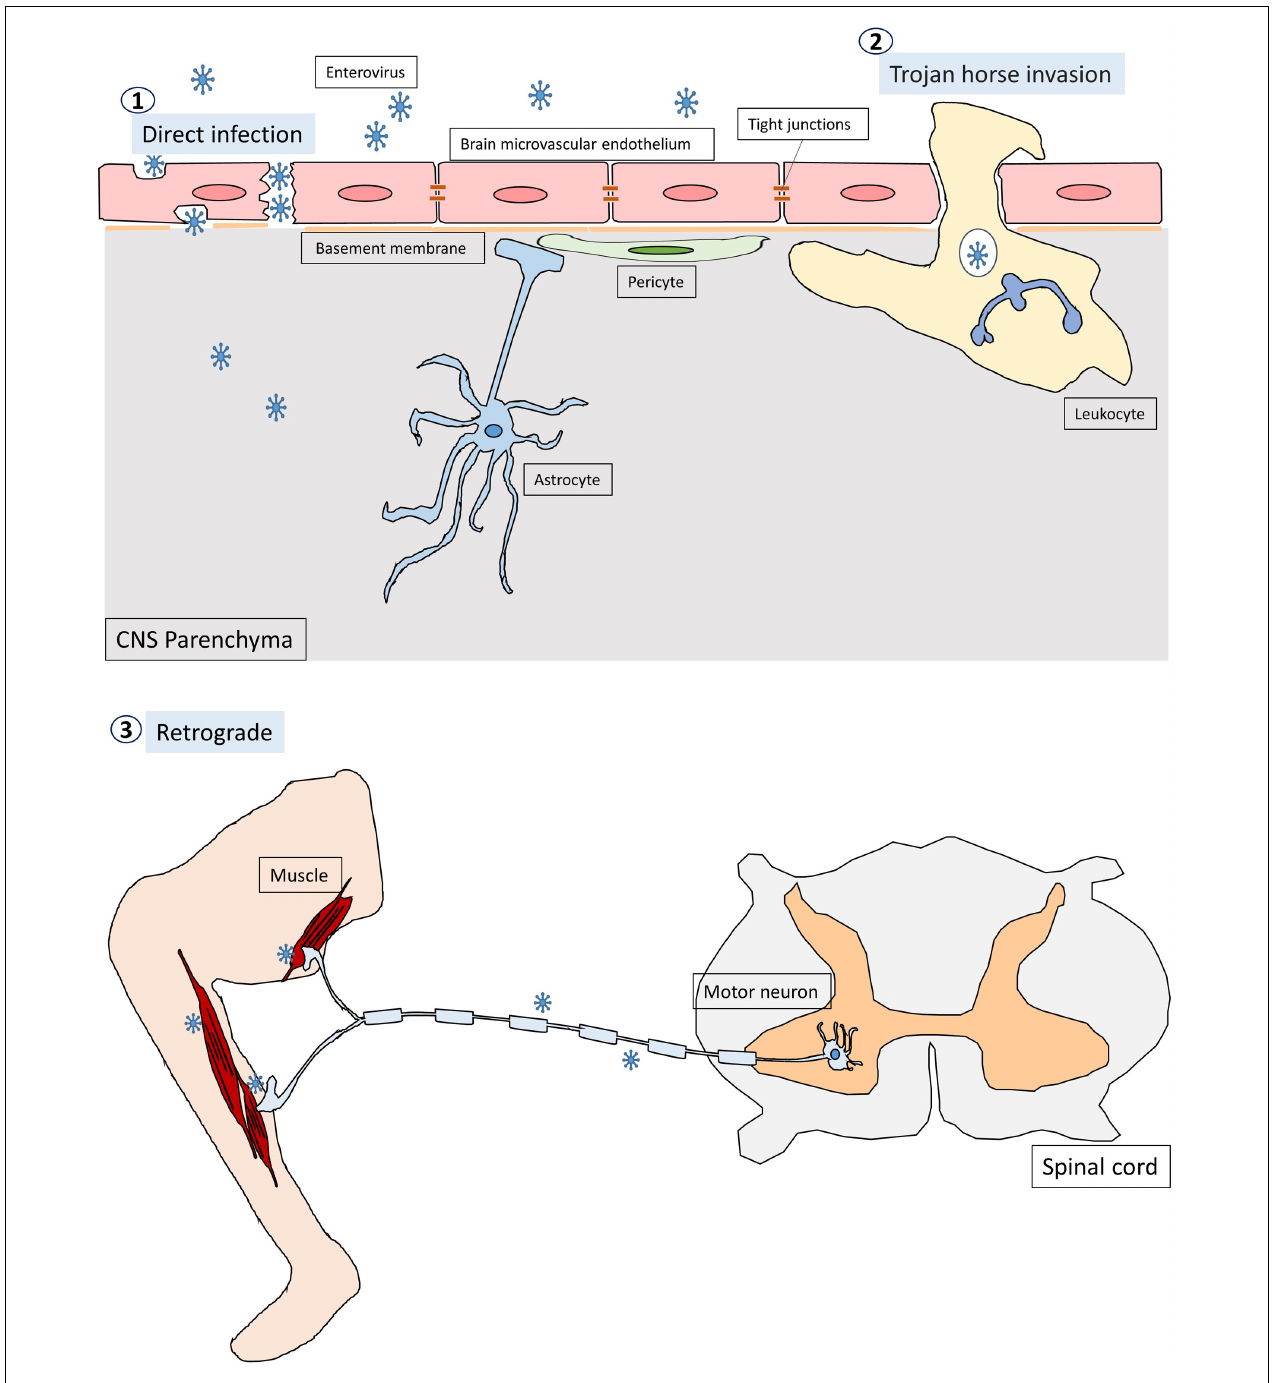
FIGURE 1 | The pathways through which enteroviruses can gain access to the CNS. Enteroviruses can invade the CNS through three pathways. First, they infect BMECs, compromising and crossing the BBB to reach the CNS directly. The second pathway is known as Trojan horse route, in which enterovirus-infected leukocytes act as carriers and transverse the brain barriers bringing virus into the CNS. Thirdly, enteroviruses are able to hijack the retrograde axonal transport to enter the CNS from muscles into the motor neurons in the spinal cord.